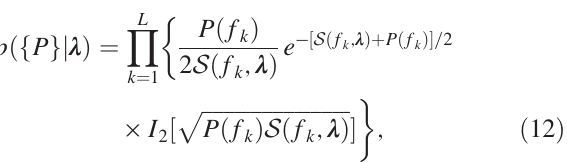
ffiffiffiffiffiffiffiffiffiffiffiffiffiffiffiffiffiffiffiffiffiffiffiffiffiffiffiffi P ð f S ð f ; λ Þ k Þ k